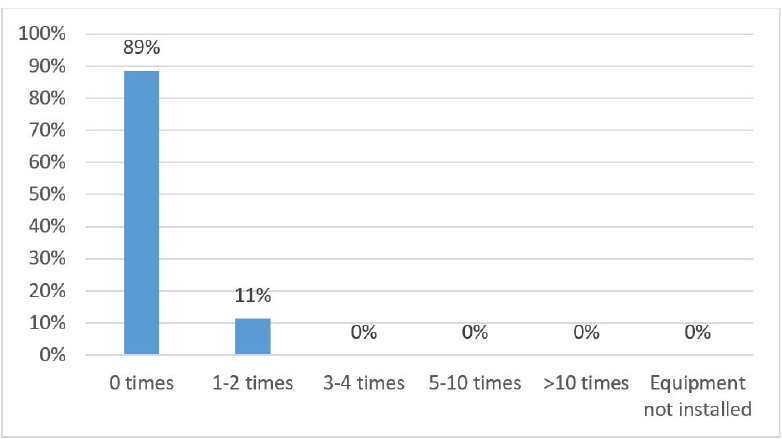
Figure 7. Frequency of use of the MF/HF DSC.